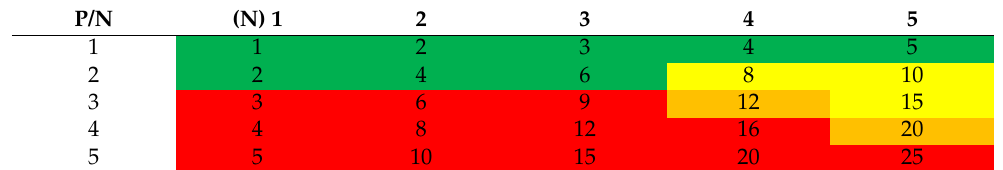
Table 2. Risk matrix for the actions of a police officer carrying out actions on the site of a traffic incident.